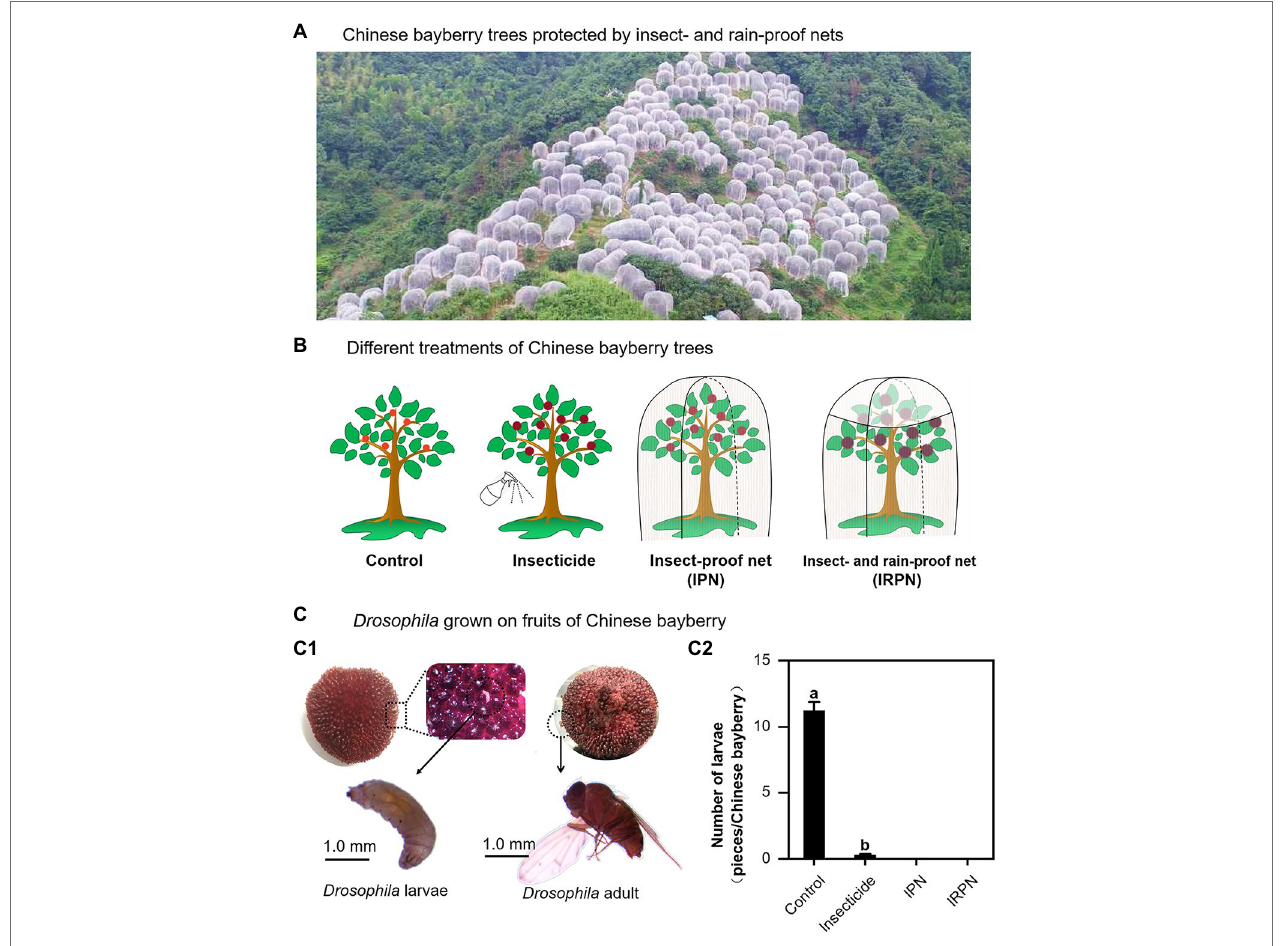
FIGURE 1 | Drosophila growth on Chinese bayberry fruits collected from trees grown in different environments. (A) Field image of Chinese bayberry trees protected by insect-proof nets (IPNs) and rain-proof films during the fruit maturation period. (B) The trees were grown under natural conditions (controls) or treated separately with insecticides, IPNs or insect- and rain-proof nets (IRPNs). (C) Drosophila (C1) and number of Drosophila (C2) on Chinese bayberry fruits collected from untreated and treated